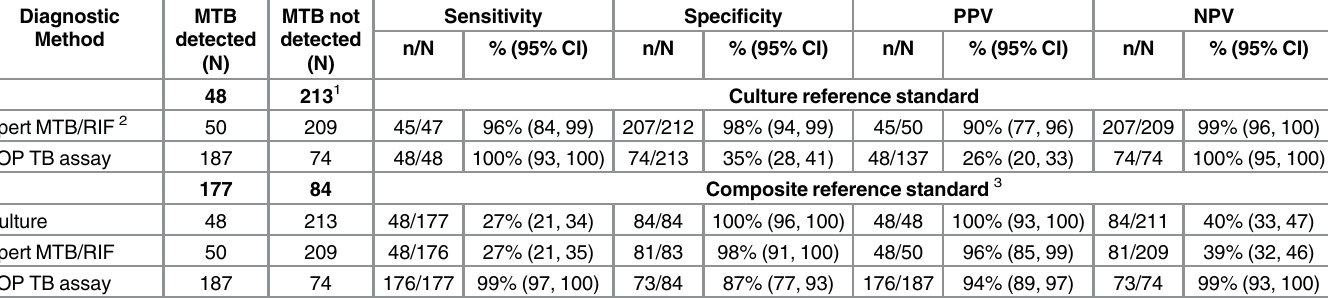
Table 2. Per-patient sensitivity and specificity of the TOP TB assay, Xpert MTB/RIF and culture in 261 HIV-infected tuberculosis suspects accord- ing to a reference standard established by M . tuberculosis culture or a Composite Reference Standard (CRS) in Mbarara, Uganda. Diagnostic